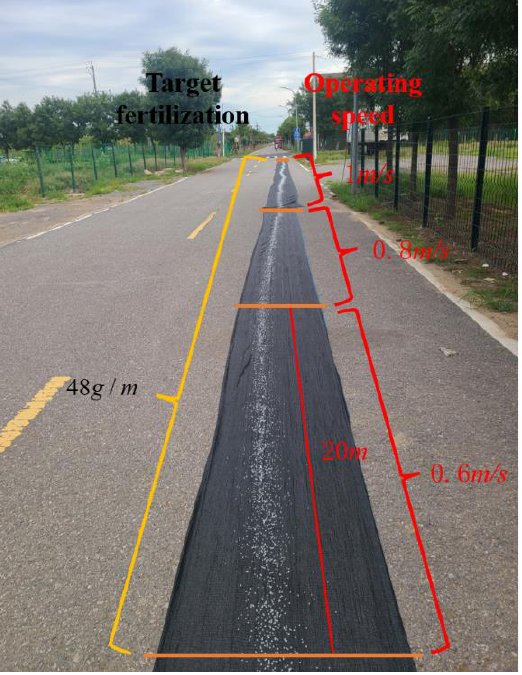
Table 8. Fertilizer discharge accuracy test of variable-rate fertilization system at different speeds.